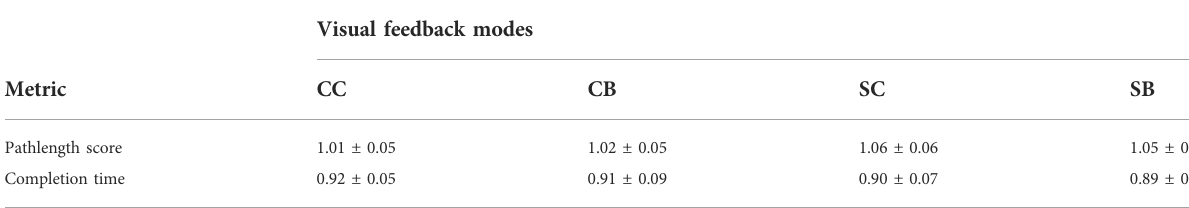
Table 1B: Two-way ANOVA results based on factors of complexity and intermittency